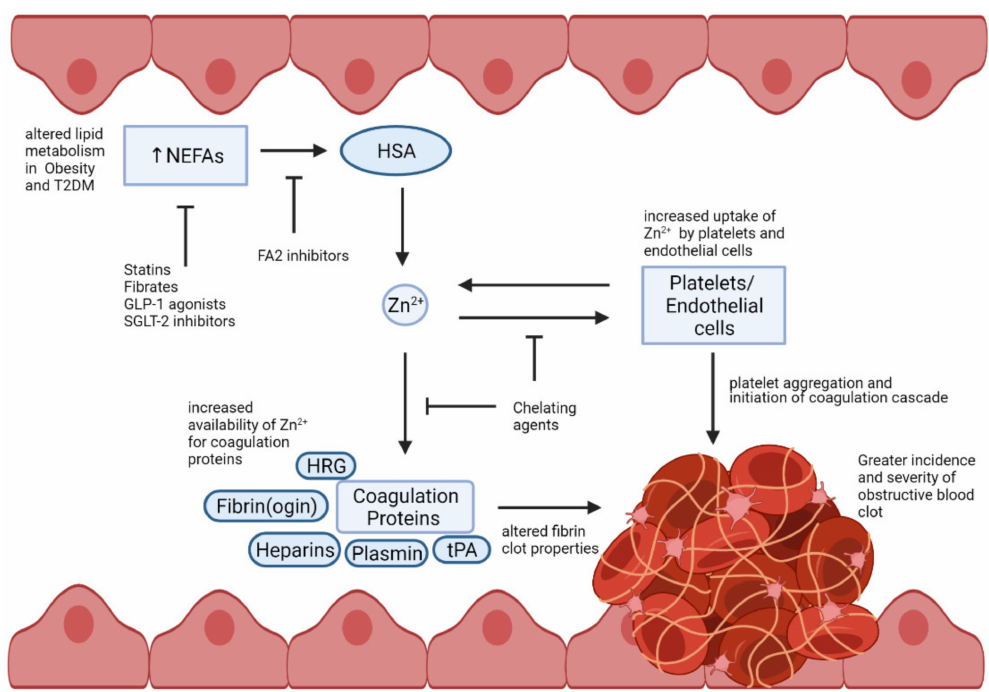
Figure 3. Potential Zn 2+ -mediated thrombotic routes in obesity and T2DM and targets for therapy. Altered lipid metabolism in obesity and T2DM results in elevated NEFA levels in the blood. NEFA binding at the FA2 site of HSA prevents procoagulant Zn 2+ ions from binding at site A. The Zn 2+ unable to bind HSA is redistributed among the cellular and protein components of the homeostatic mechanism, resulting in thrombotic events. This mechanism of thrombosis can be targeted by using lipid- and glucose-lowering drugs, which lower plasma NEFA levels. Therapeutics with chelating properties may also have potential to prevent free Zn 2+ ions interacting with homeostatic components. FA2 inhibitors could also be developed to restore Zn 2+ buffering by HSA. Created with BioRender.com (accessed on 13 September